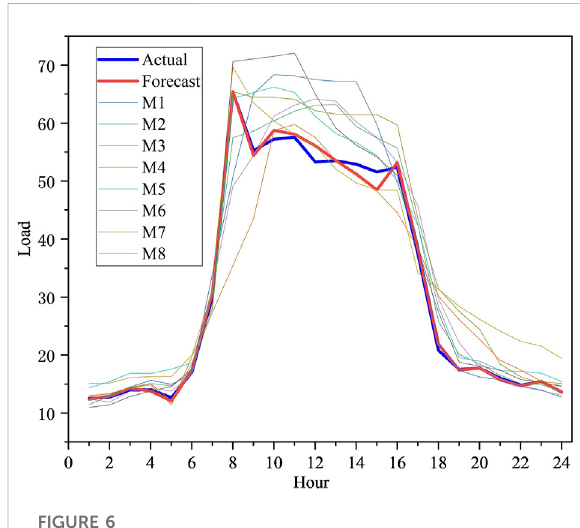
FIGURE 6 Time series of predicted load and actual load for one